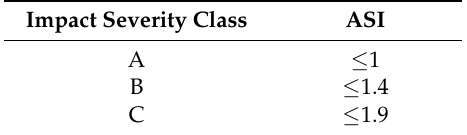
Table 1. Impact severity classes [8]. ASI: acceleration severity